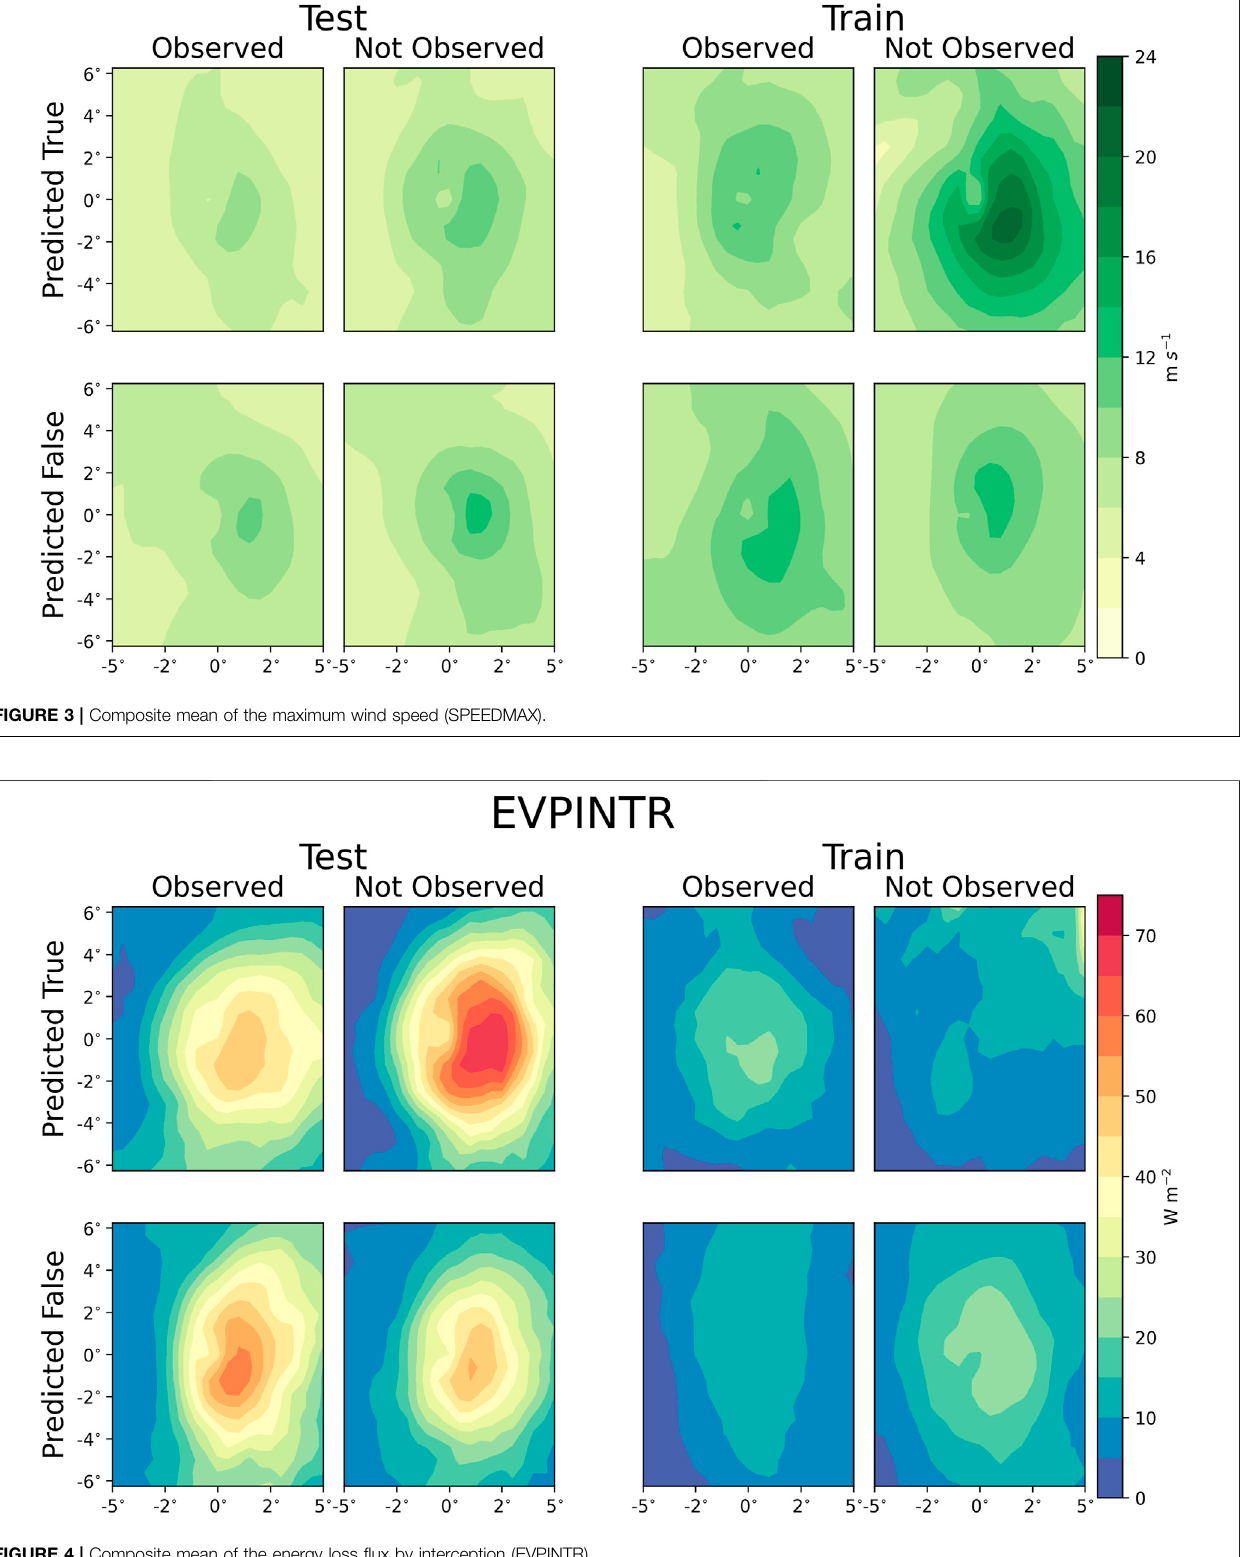
Frontiers in Earth Science |